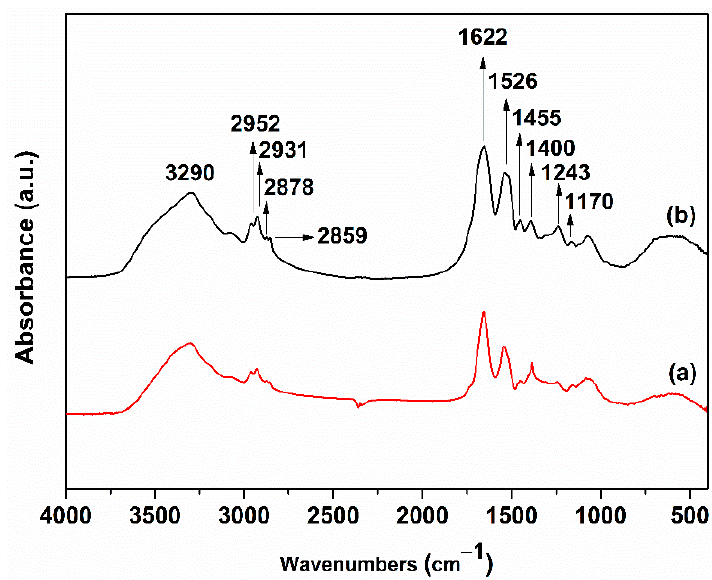
Figure 4. X-ray diffraction of the as-synthesized AgNPs.